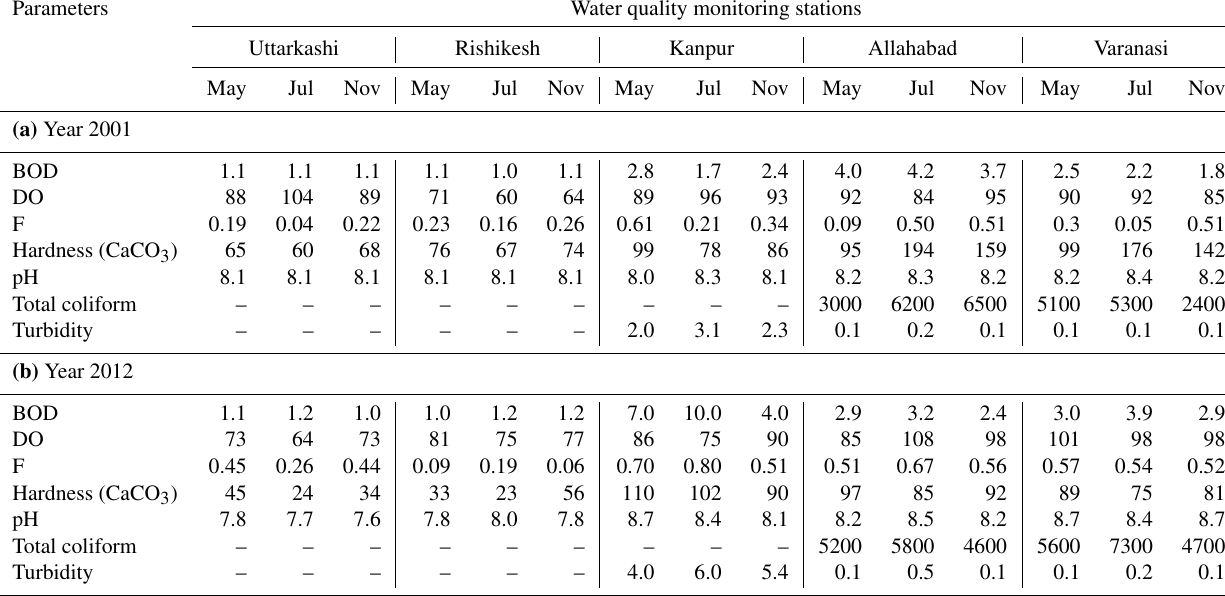
Table 8. Water quality parameters across the Upper Ganga River basin for premonsoon, monsoon and postmonsoon seasons over periods of 2001–2012. Units: BOD = mgL − 1 ; DO = %; F = mgL − 1 ; hardness (CaCO 3 ) = mgL − 1 ; pH = no unit; total coliform = MPN; turbid- ity = NTU.